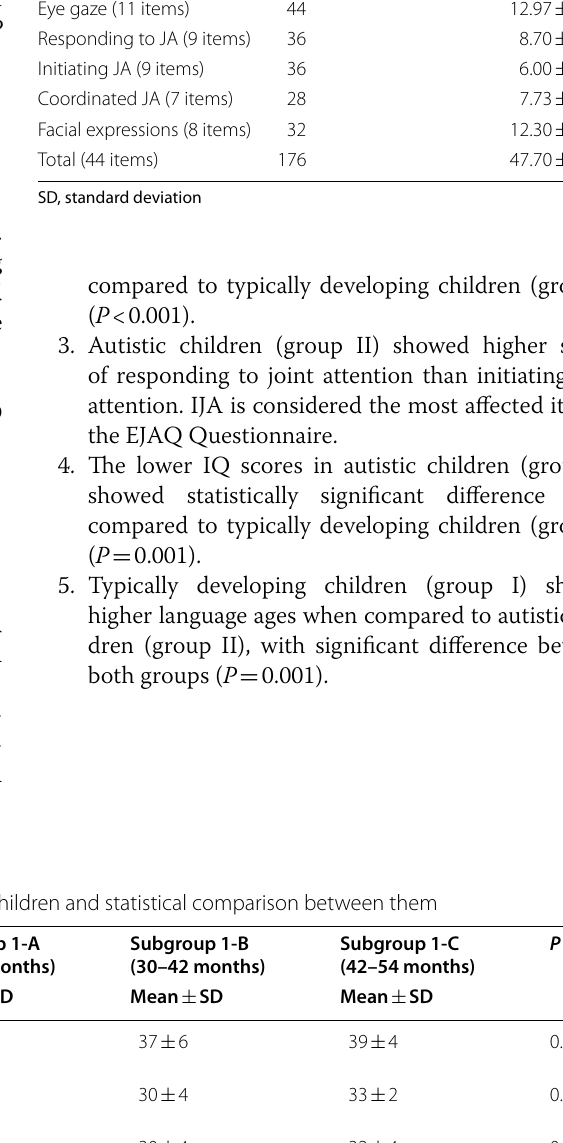
SD. Test used: ONE-WAY ANOVA ±